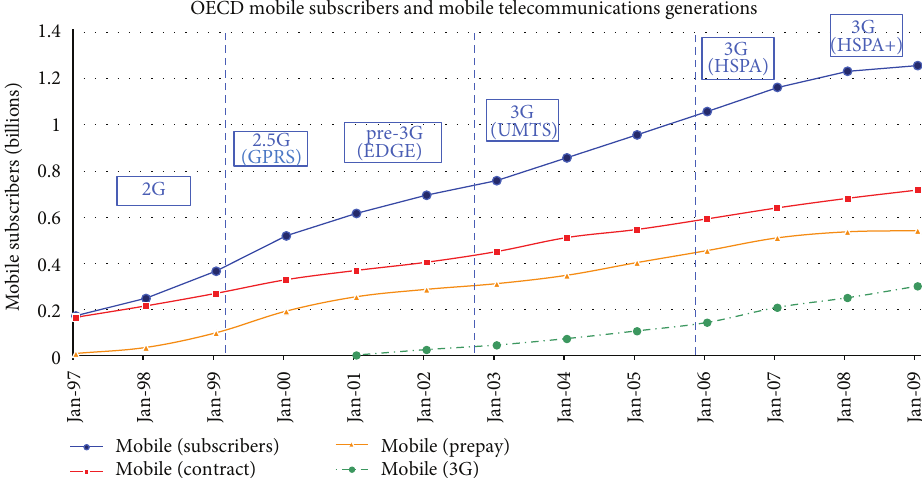
Figure 10: OECD mobile subscribers (in billions).